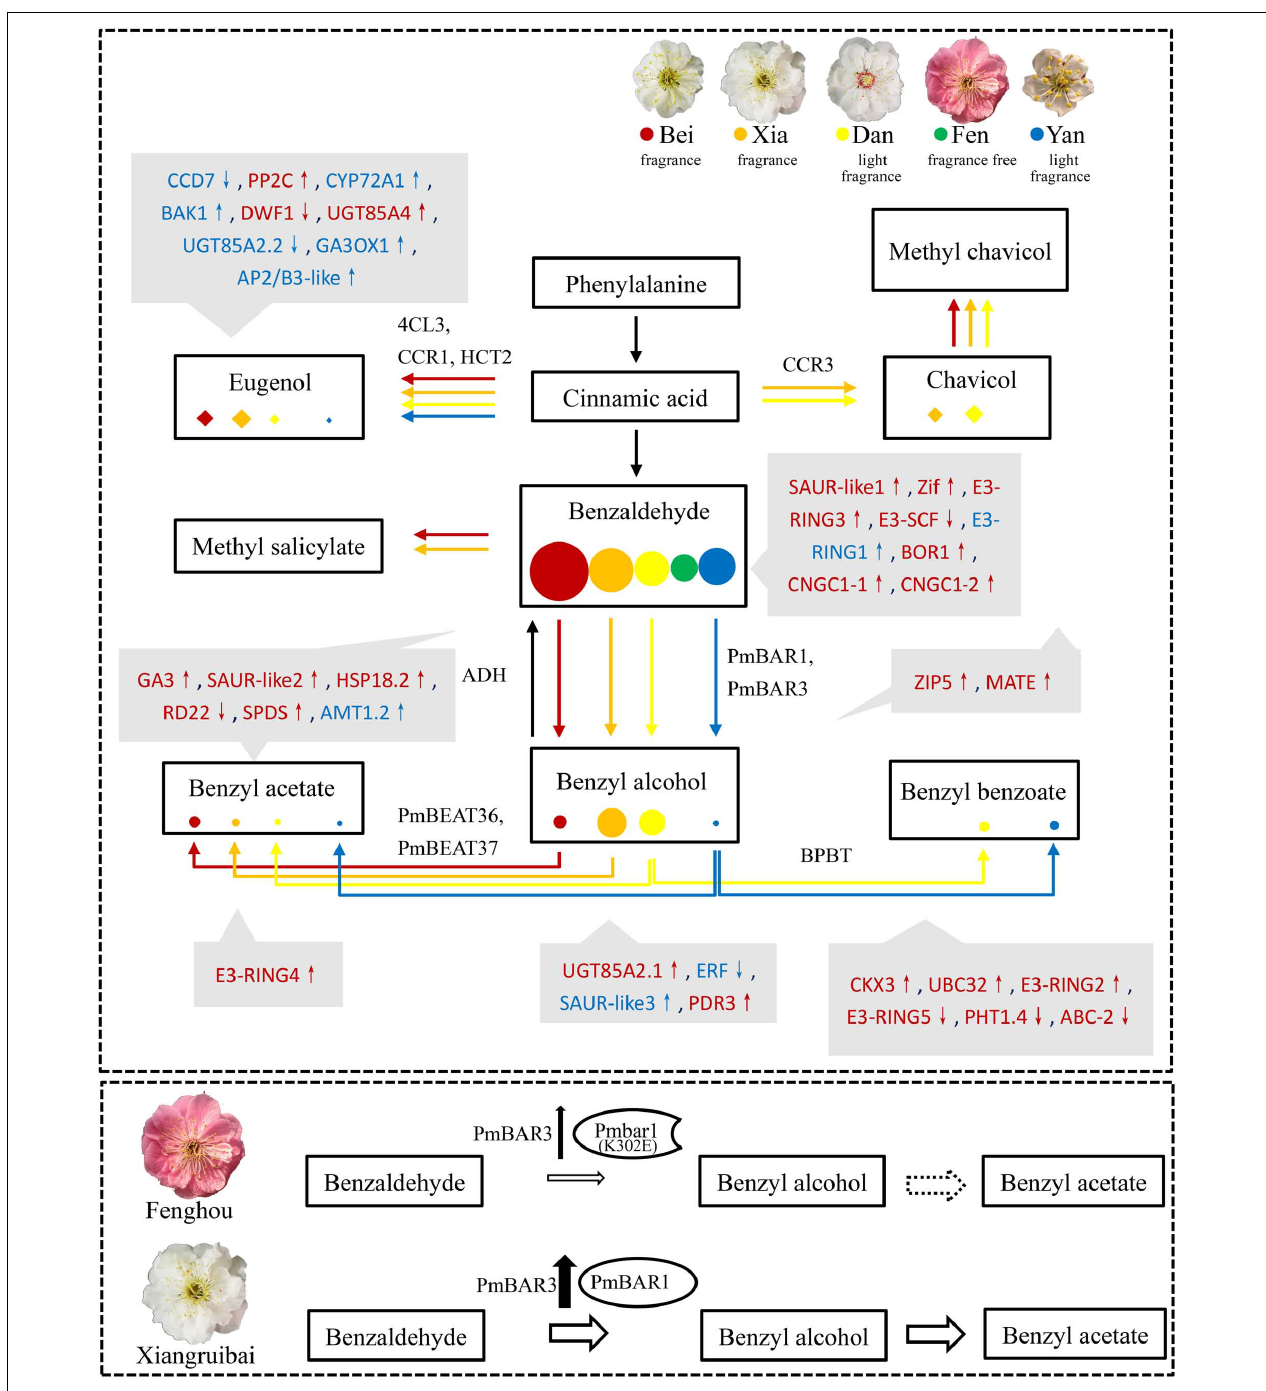
FIGURE 8 | Summary of metabolic flux and differential regulation in the floral scent synthesis pathways of the five varieties. The synthesis pathways of eugenol and benzyl acetate are separated into two metabolic fluxes. The highly correlated genes that may affect the synthesis of floral scent metabolites are shown in gray boxes. Red and blue indicate positively and negatively correlated genes, respectively. Hormones-related genes: CCD7, PP2C, CYP72A1, BAK1, DWF1, UGT85A2.1, UGT85A2.2, UGT85A4, GA3, GA3OX1, SAUR-like1 SAUR-like2, SAUR-like3, ERF, CKX3. Transcript factors: AP3/B3-like, Zif. Ubiquitin modification-related genes: E3-SCF, E3-RING1, E3-RING2, E3-RING3, E3-RING4, E3-RING5, UBC32. Stress-related genes: HSP18.2, RD22, SPDS. Transporters: BOR1, CNGC1-1, CNGC1-2, AMT1.2, ZIP5, MATE, PDR3, PHT1.4, ABC-2. Upward arrows indicate upregulated genes in blooming flowers, while downward arrows indicate downregulated genes in blooming flowers. The enzymes catalyzing the corresponding reaction are beside the arrows. The sizes of the colored circles and diamonds represent the abundances of metabolites in intracellular pools in the five varieties. A working model of the PmBAR-related mechanism underlying the benzyl acetate synthesis dysfunction in the “Fenghou” variety is shown in the image below. The size of the arrow represents the content, and the dotted line indicates non-existence.